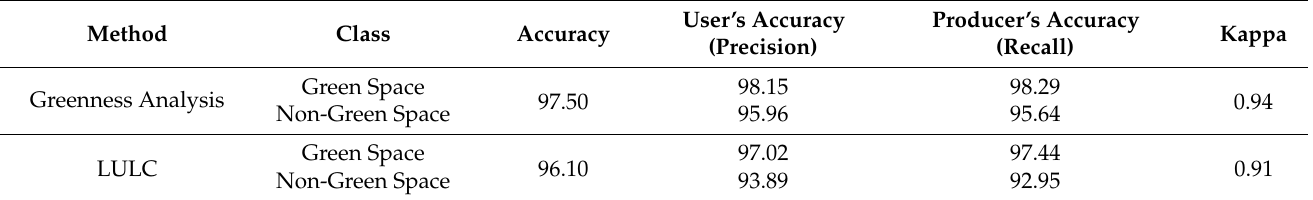
Table 3. The assessment results of individual classifications by using greenness analysis and based on LULC data.